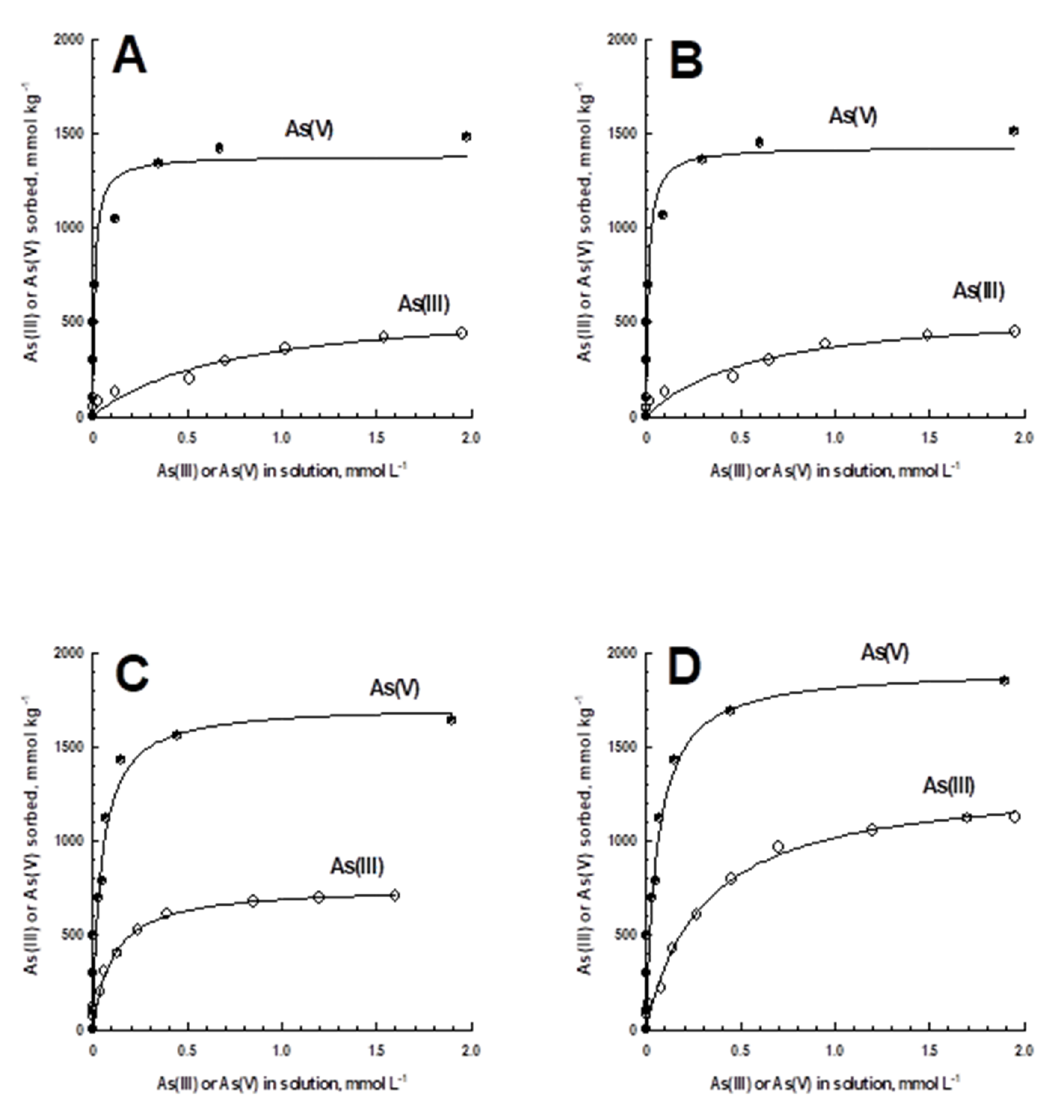
Figure 2. Adsorption isotherms of As(III) and As(V) onto Zn-Al ( A ), Mg-Al ( B ), Cu-Al ( C ) and Mg-Fe ( D ) layered double hydroxides, at pH = 7 and 20 °C, after 24 h of reaction time (As(III) data from Pigna et al. [24]).